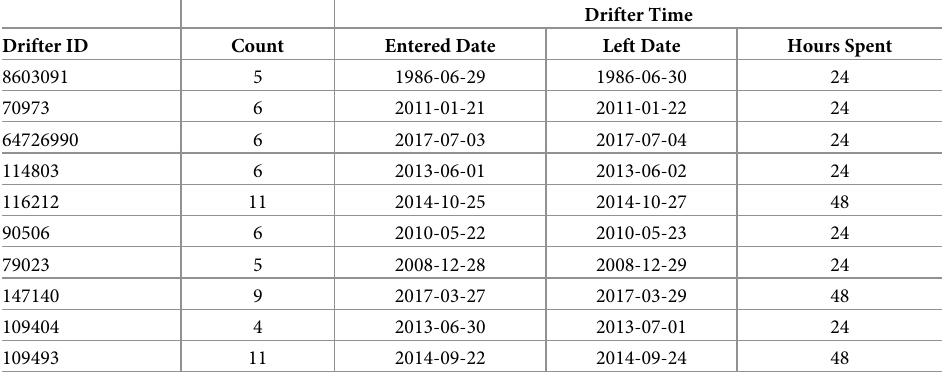
Table 1. A random sample of observations from twelve unique drifters that crossed the Pemba channel at differ- ent times.